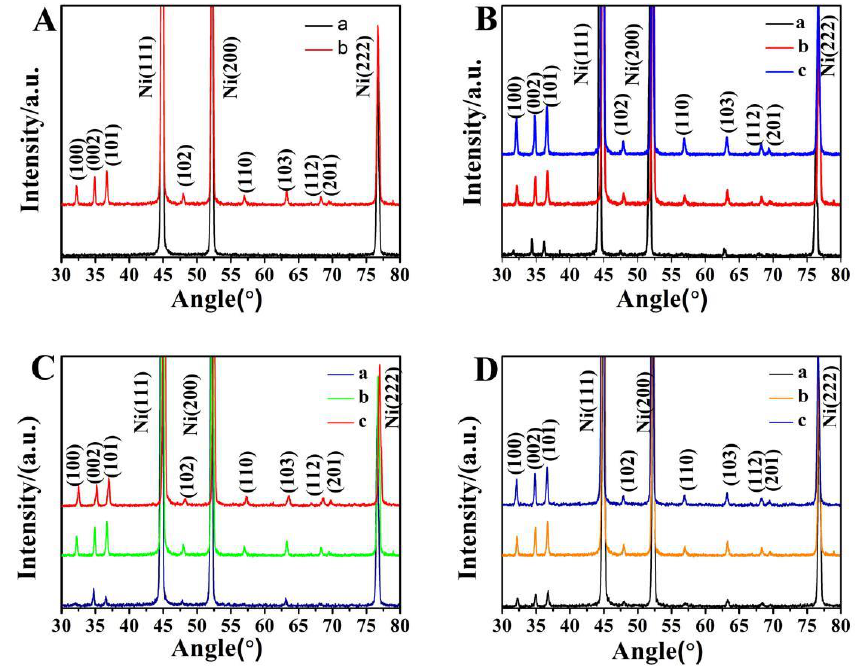
Figure 5. ( A ) (a): XRD images of well-grown nanorods, and (b): XRD images of ungrown nanorods. ( B ) XRD images of ZnO grown at different concentrations: (a) 20 mmol/L, (b) 40 mmol/L, and (c) 60 mmol/L. ( C ) XRD images of ZnO grown at different times: (a) 2 h, (b) 4 h, and (c) 6 h. ( D ) XRD images of ZnO grown at different temperatures: (a) 75 °C, (b) 95 °C, and (c) 115 °C. Figure 6A shows that nickel foam has a strong absorption of light in the ultraviolet range, but there is obvious fluctuation in light absorption in the 200–400 nm optical band. After sputtering a layer of ZnO seed on the surface of the foamed nickel, the light absorption peak is broadened in the 200–400 nm optical band; due to the scattering effect of light, the phenomenon of spectrum offset (blue shift) is exhibited. Figure 6B shows that when the solution concentration is low, the absorption of light mainly comes from foamed nickel, due to the growth of ZnO nanorods are sparse and short.